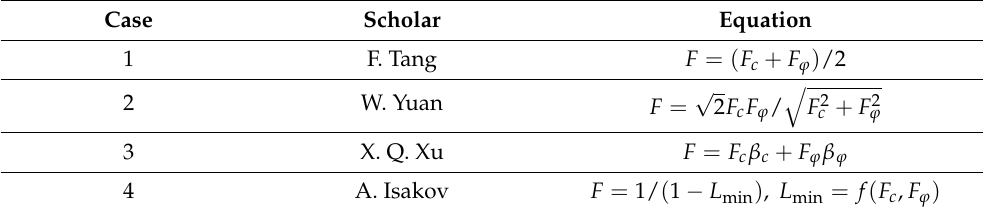
Table 1. Variant approaches to determining the overall stability factor